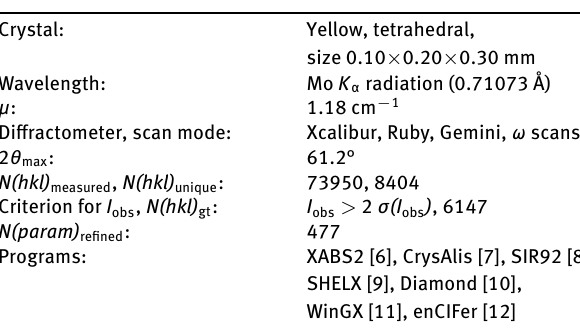
Table 1: Data collection and handling.